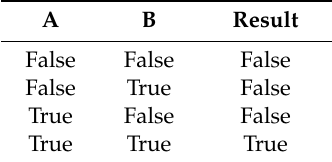
Table 1. Logical